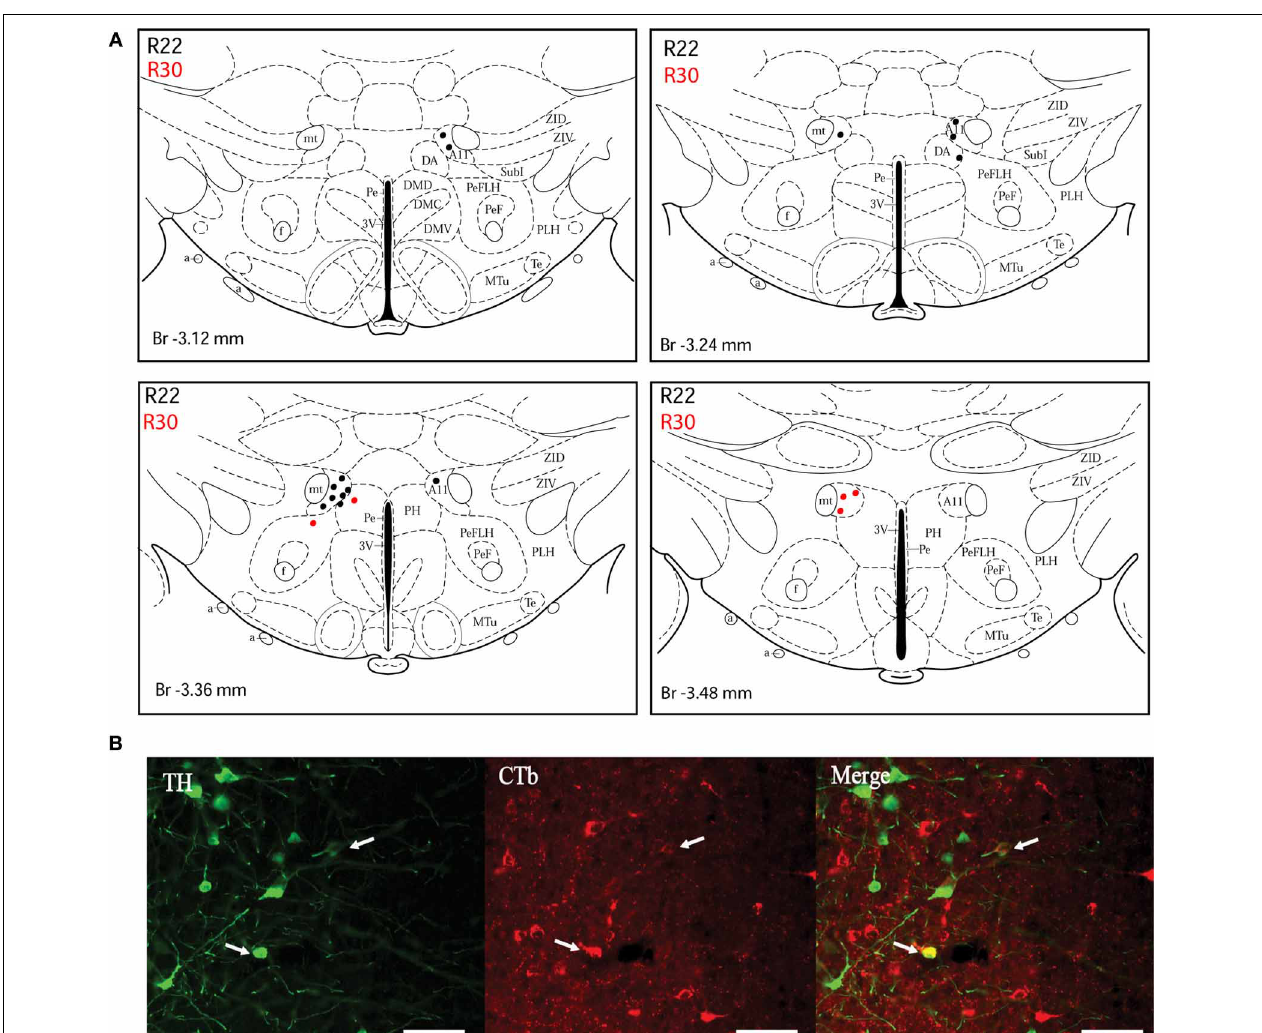
FIGURE 4 | Double-labeled neurons in the A11 dopaminergic cell group projecting to the dlPAG. (A) Distribution of CTb/TH-positive cells in the A11 cell group, cases R22 (black dots) and R30 (red dots). Figures modified from Paxinos and Watson (1998). (B) Fluorescence micrographs showing